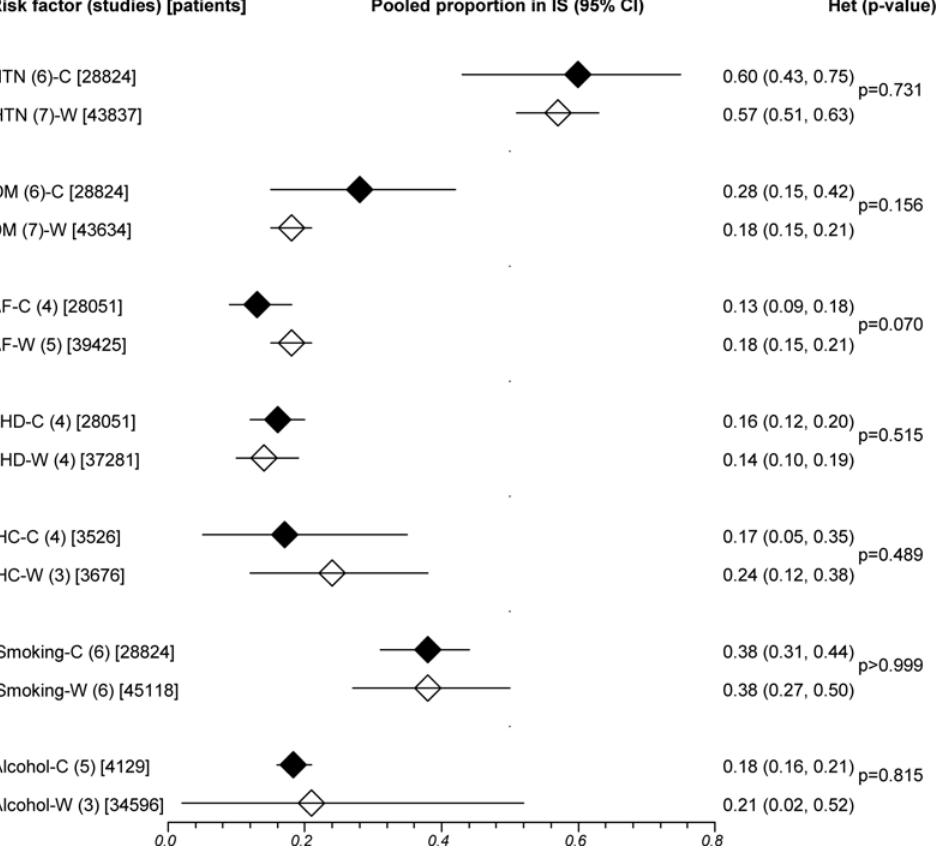
Fig 4. Pooled prevalence of risk factors in Chinese and white ischemic stroke. IS = ischemic stroke; CI = confidence interval; Betw group het = between-group (ethnic) heterogeneity; C = Chinese; W = Whites; HTN = hypertension; DM = diabetes; AF = atrial fibrillation; IHD = ischemic heart disease; HC = hypercholesterolemia. Horizontal lines represent 95% CIs. Diamonds represent pooled proportions.